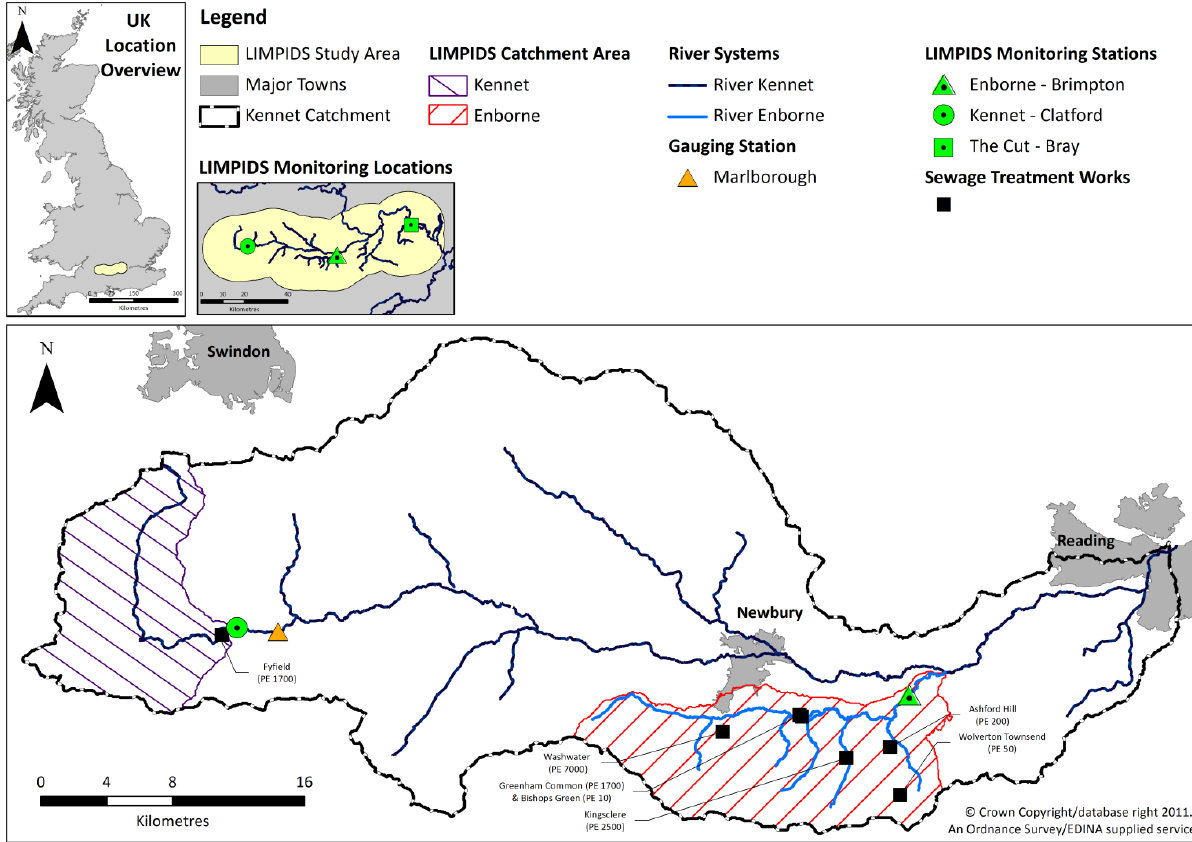
Fig. 1. The River Kennet and River Enborne study Figure 1 2